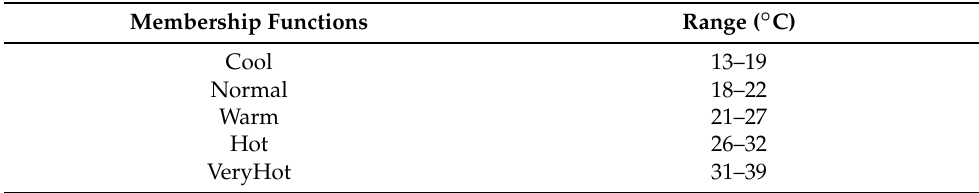
Table 3. Membership Functions for Current Temperature.